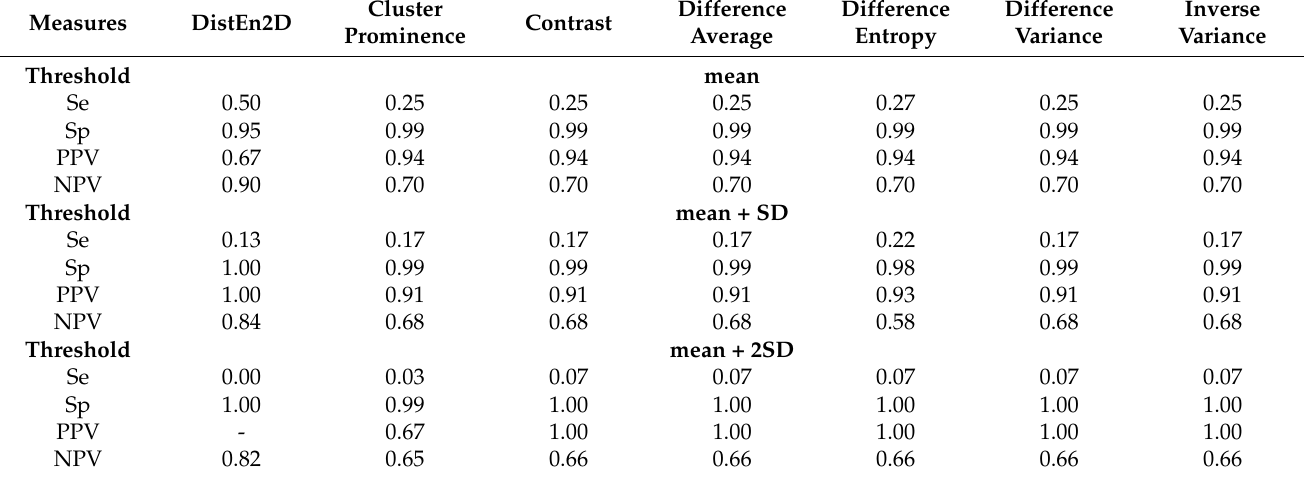
The accuracy (Se—sensitivity; Sp—specificity; PPV—positive predictive value; NPV—negative predictive value) of the detection of EOTRH 0 and EOTRH 3 based on the selected entropy measure (DistEn2D—two–dimensional distribution entropy) and the selected Gray–Level Co–occurrence Matrix (GLCM) features (ClusterProminence; Contrast; DifferenceAverage; Differ- enceEntropy; DifferenceVariance; Inverse Variance) extracted from the output images filtered by Normalize filter. Three thresholds (mean; mean + SD; mean + 2SD) were